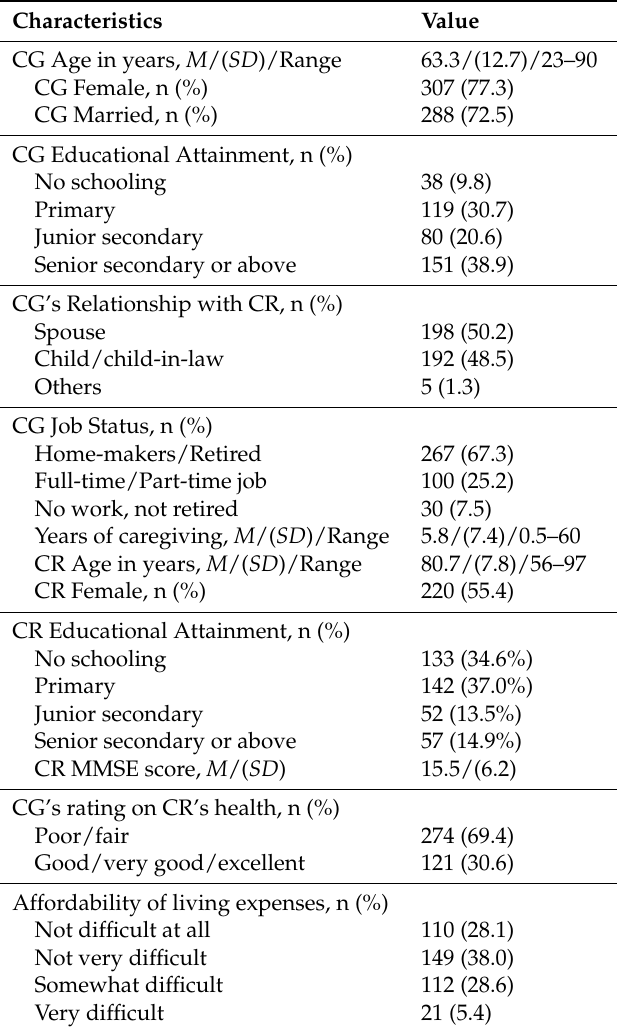
Table 1. Characteristics of sample (N =